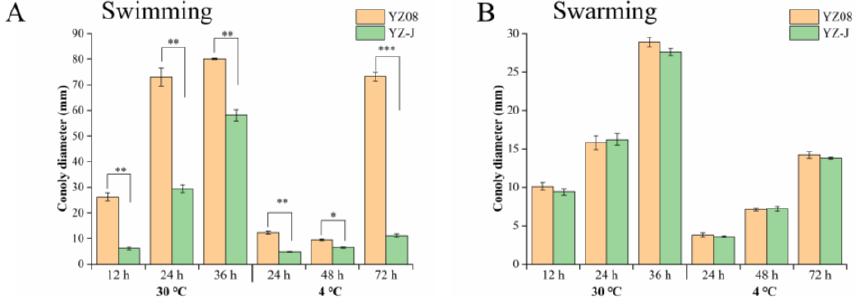
Figure 6. Swimming ( A ) and swarming ( B ) motility of S. putrefaciens YZ08 and YZ-J in LB performed at 15 and 30 °C. no mark p > 0.05, * p < 0.05, ** p < 0.01, *** p < 0.001.